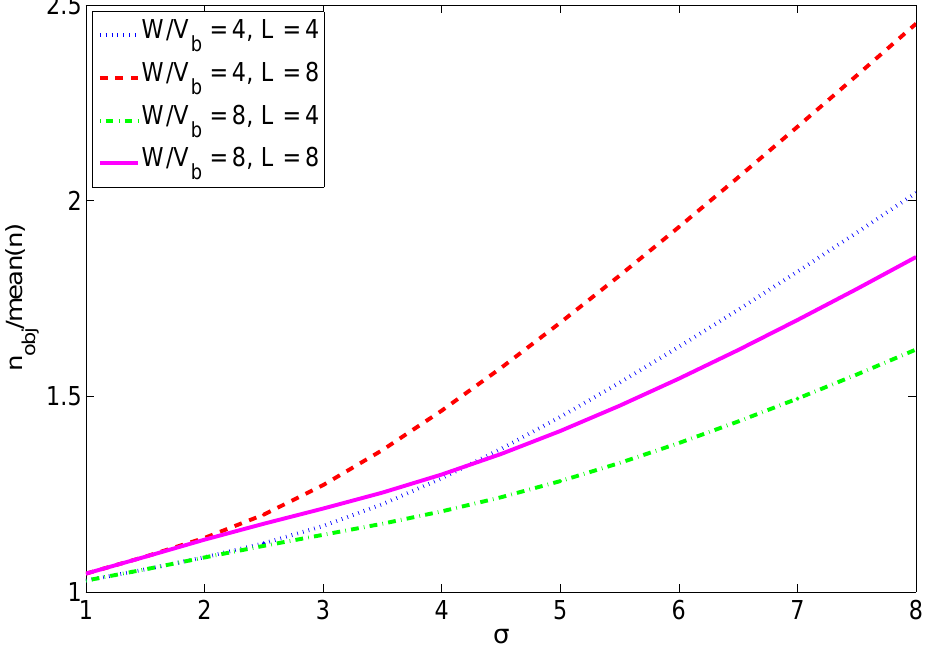
Figure 3. Ratio between the desired number of received packets and the mean value of n